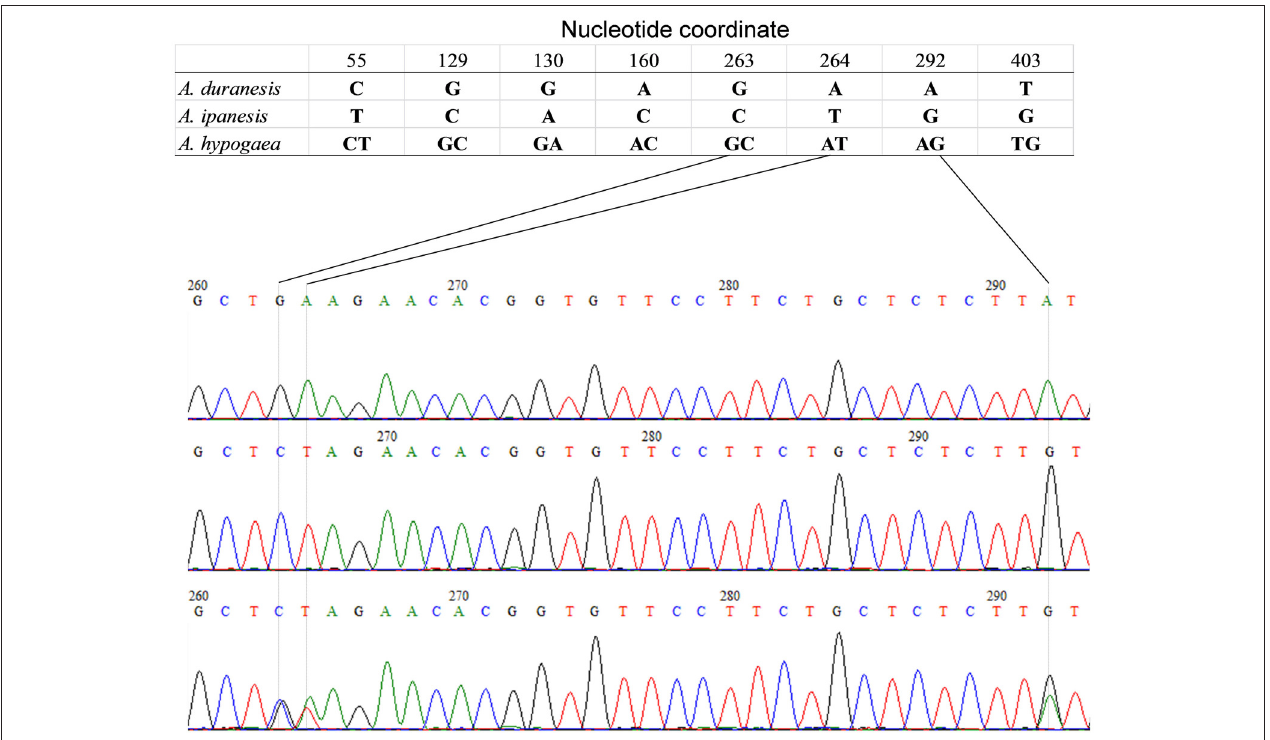
FIGURE 1 | Amplicon Sequence of EST-48 in A. hypogaea and putative diploid progenitor. The figure shows that the A. duranensis and A. ipaensis genomes each contained single copy of sequence “EST-48” while both the copies were retained in A. hypogaea genome.